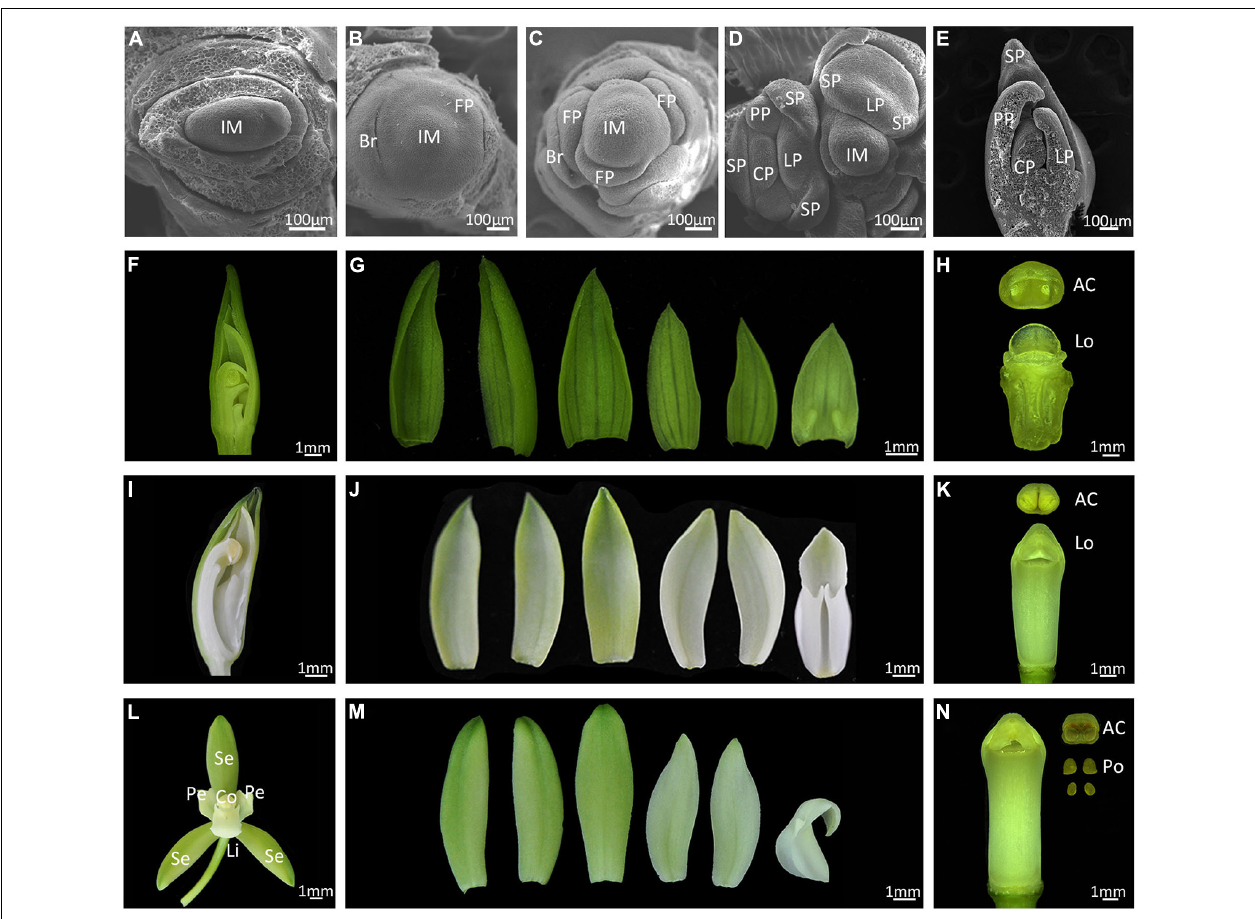
FIGURE 1 | Floral development of Cymbidium ensifolium. (A–E) Scanning electron micrograph (SEM) of early floral developmental stages. Bar = 100 µ m. Im, inflorescence meristem; Br, bract; FP, floret primordium; SP, sepal primordium; PP, petal primordium; LP, labellum primordium; CP, column primordium. (F–N) Developing flowers, Bar = 1 mm. The developing flower of stage 3 (F–H) , stage 4 (I–K) , and mature flowers (L–N) . Se, sepal; Pe, petal; Li, lip; Co, column; AC, Anther Cap; Lo, locule; Po,